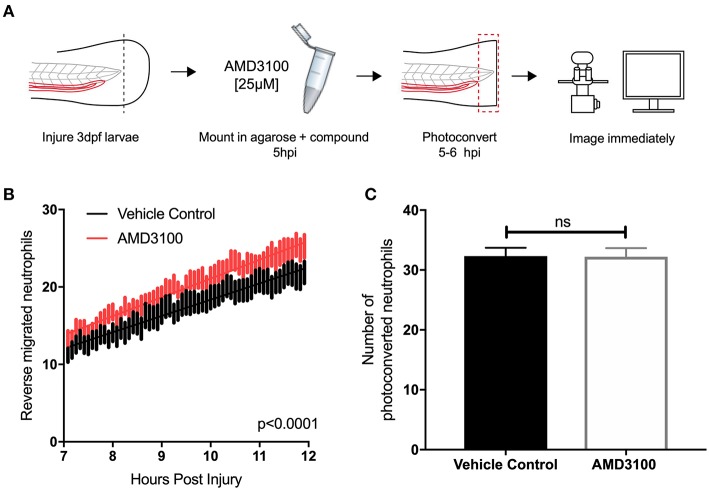
Inhibition of CXCR4 using AMD3100 accelerates neutrophil reverse migration. (A) Experimental schematic of neutrophil reverse migration assay. Tail fin transection was performed on 3 dpf mpx:kaede larvae. Larvae were mounted in a 1% agarose solution containing AMD3100 or vehicle control at 5 hpi. Neutrophils at the wound site were photoconverted at 5 hpi from green to red fluorescence. Time lapse imaging was performed from 7 to 12hpi. (B) The number of neutrophils which moved away from the wound site into a defined region of interest was quantified from 7 to 12 h post injury in larvae treated with a vehicle control (black) or AMD3100 (red). Error bars shown are SEM, line of best fit shown is calculated by linear regression. P-value shown is for the difference between the two slopes p < 0.0001, n = 35 larvae from 6 independent experiments. (C) Number of neutrophils photoconverted between 5 and 6 h post injury in larvae treated with vehicle control or AMD3100. Data shown are mean ± SEM, groups were analyzed using an unpaired t-test.